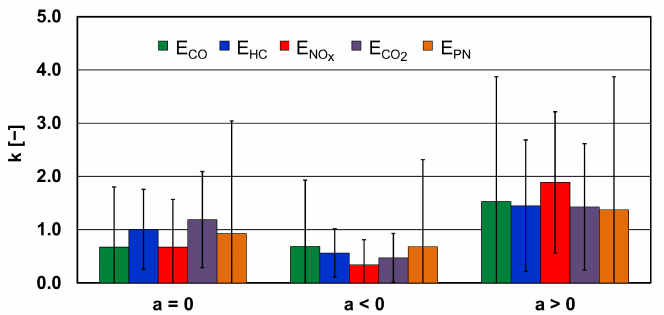
Figure 9. The ratio of the value of average emission intensity of individual components and the particle number intensity in the analyzed model and the average value in the entire